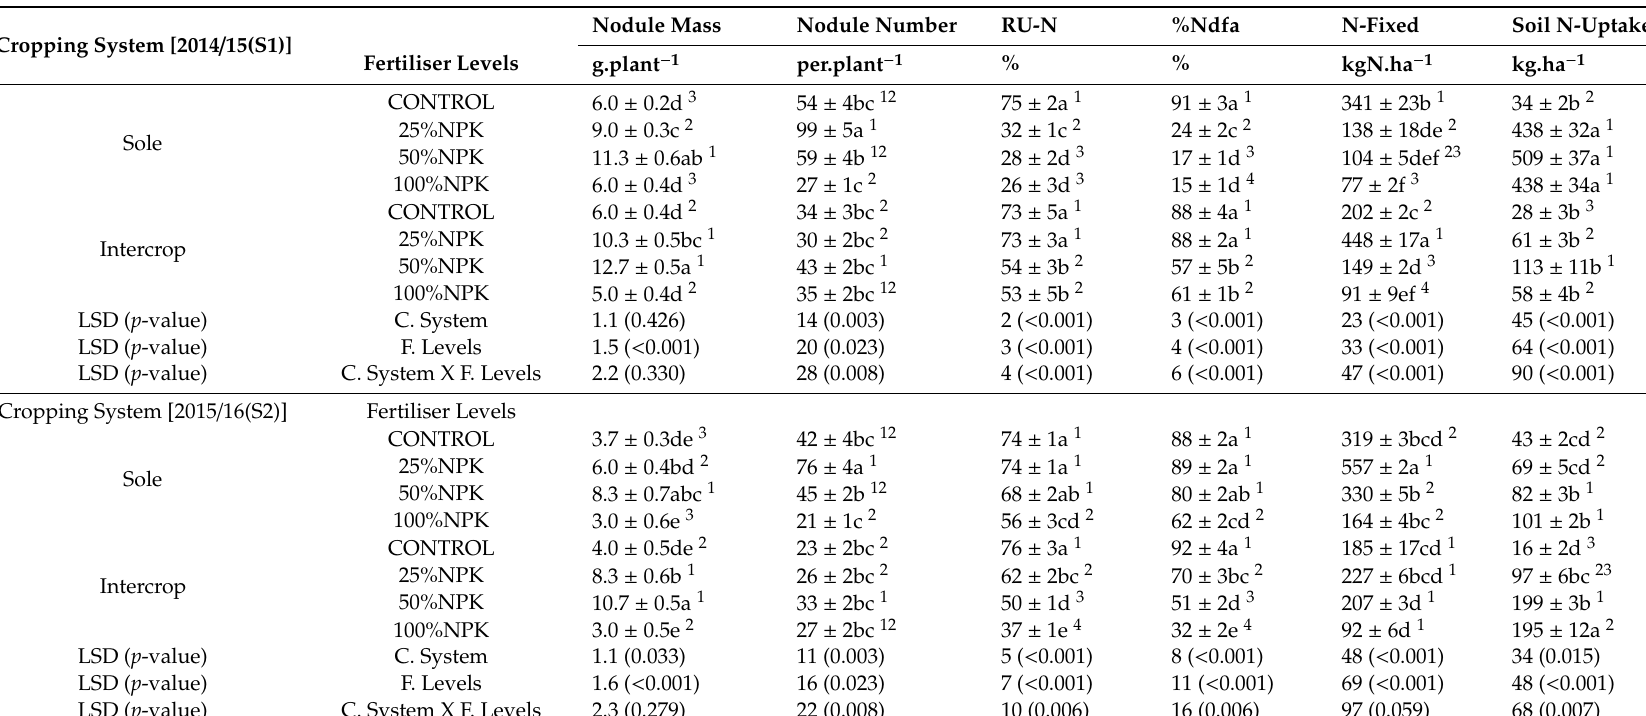
Table 3. Nodule mass, number of nodules, %RU-N, %Ndfa, N-fixed and soil N uptake of cowpea fertilised with four di ff erent fertiliser (NPK) levels in 2014 / 15 and 2015 / 16